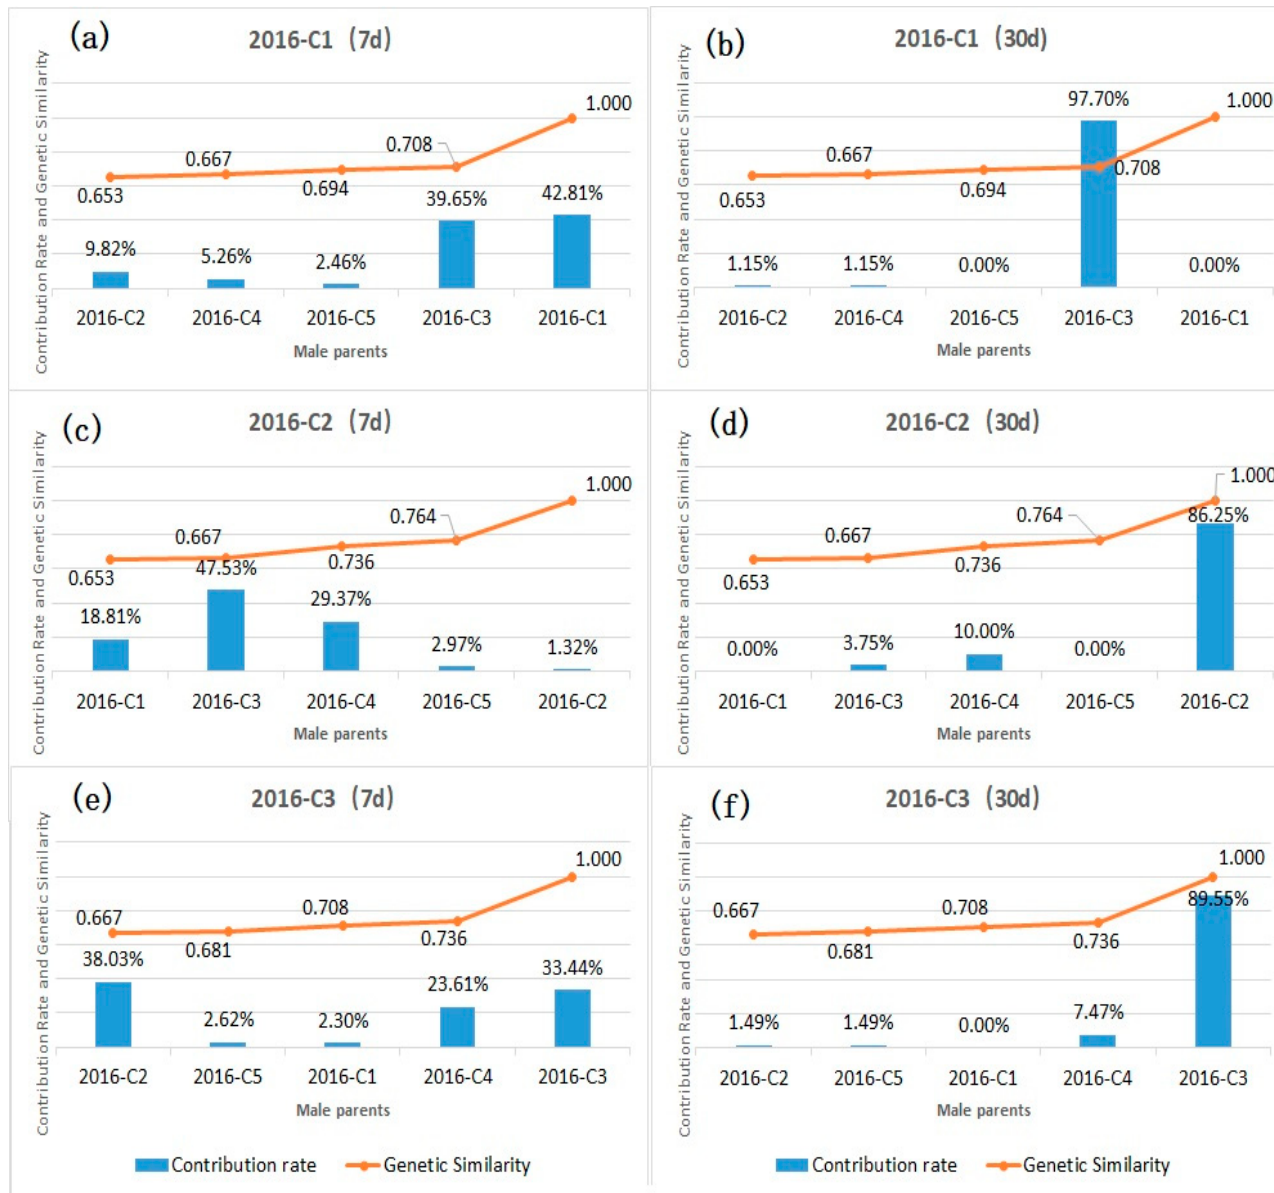
Figure 7. Contribution rate of each male parent and genetic similarity between each male parent and the female parent for the hybrid combinations: ( a ) ♀ 2016-C1, ( c ) ♀ 2016-C2, and ( e ) ♀ 2016-C3 at 7 days after pollination, and ( b ) ♀ 2016-C1, ( d ) ♀ 2016-C2, and ( f ) ♀ 2016-C3 at 30 days after pollination.